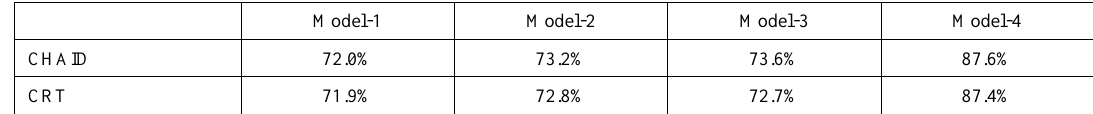
Table 8. ROC of Decision tree using CHAID and